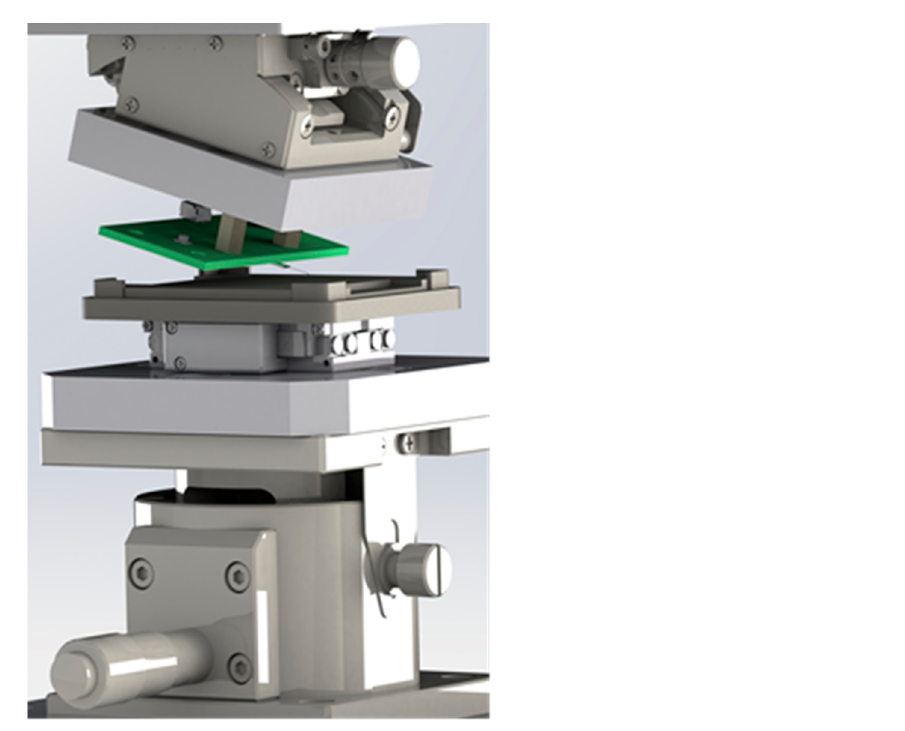
Figure 2. Schematic representation of the measurement setup. The translator, based on a piezoelec- tric drive, functions as a datum for the profile measurement and is controlled by the servo controller.